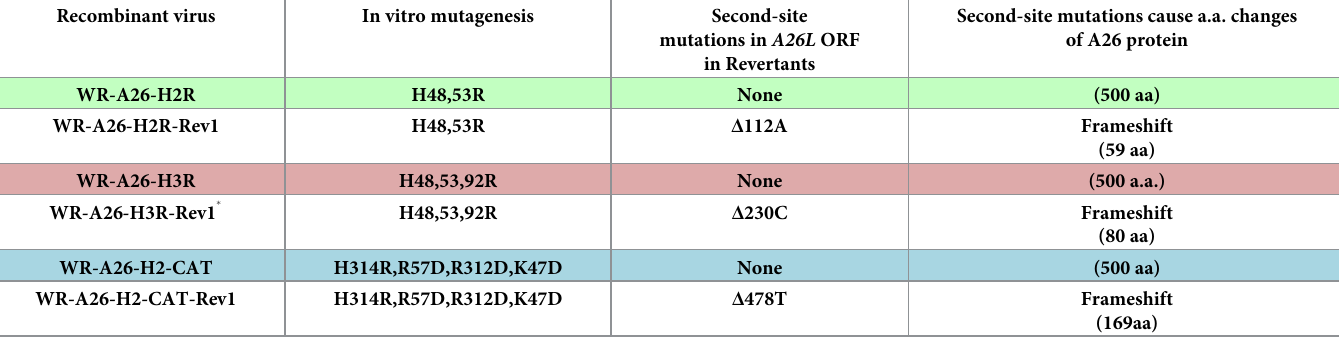
Table 4. Whole genome sequencing of A26 revertant viruses derived from WR-A26-H2R, WR-A26-H3R and WR-A26-H2-CAT mutants. Recombinant